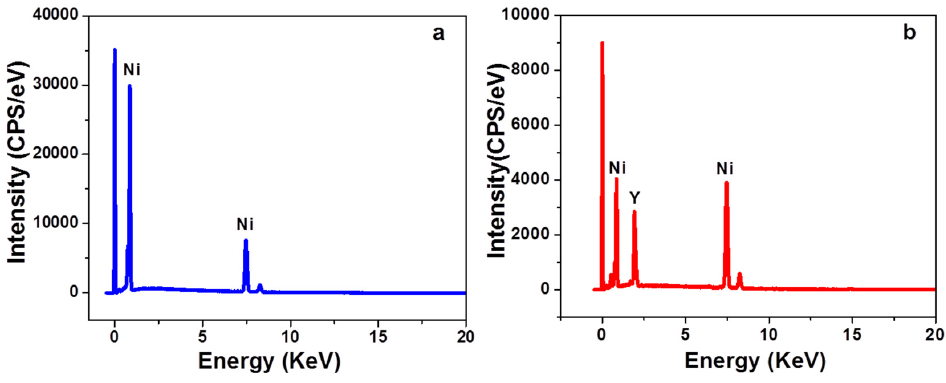
Figure 2. EDX analysis of electrodeposited Ni-B ( a ) and Ni-B-Y 2 O 3 ( b ) composite coatings.